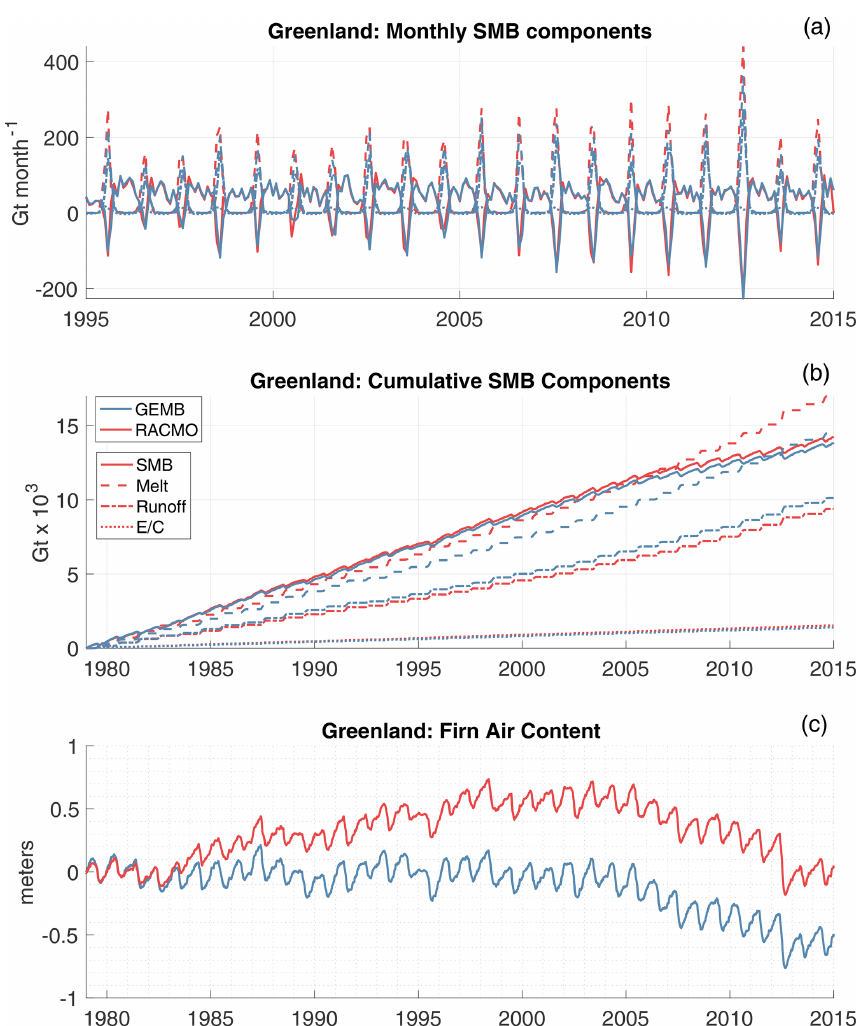
Figure 8. The 1979–2014 Greenland Ice Sheet GEMB (blue) and RACMO (red) monthly (a) and cumulative (b) model output. GEMB (blue) and IMAU-FDM (red) average fin air content anomaly, relative to 1979, is shown in panel (c) . E/C is the mass change due to evaporation, condensation, sublimation, and